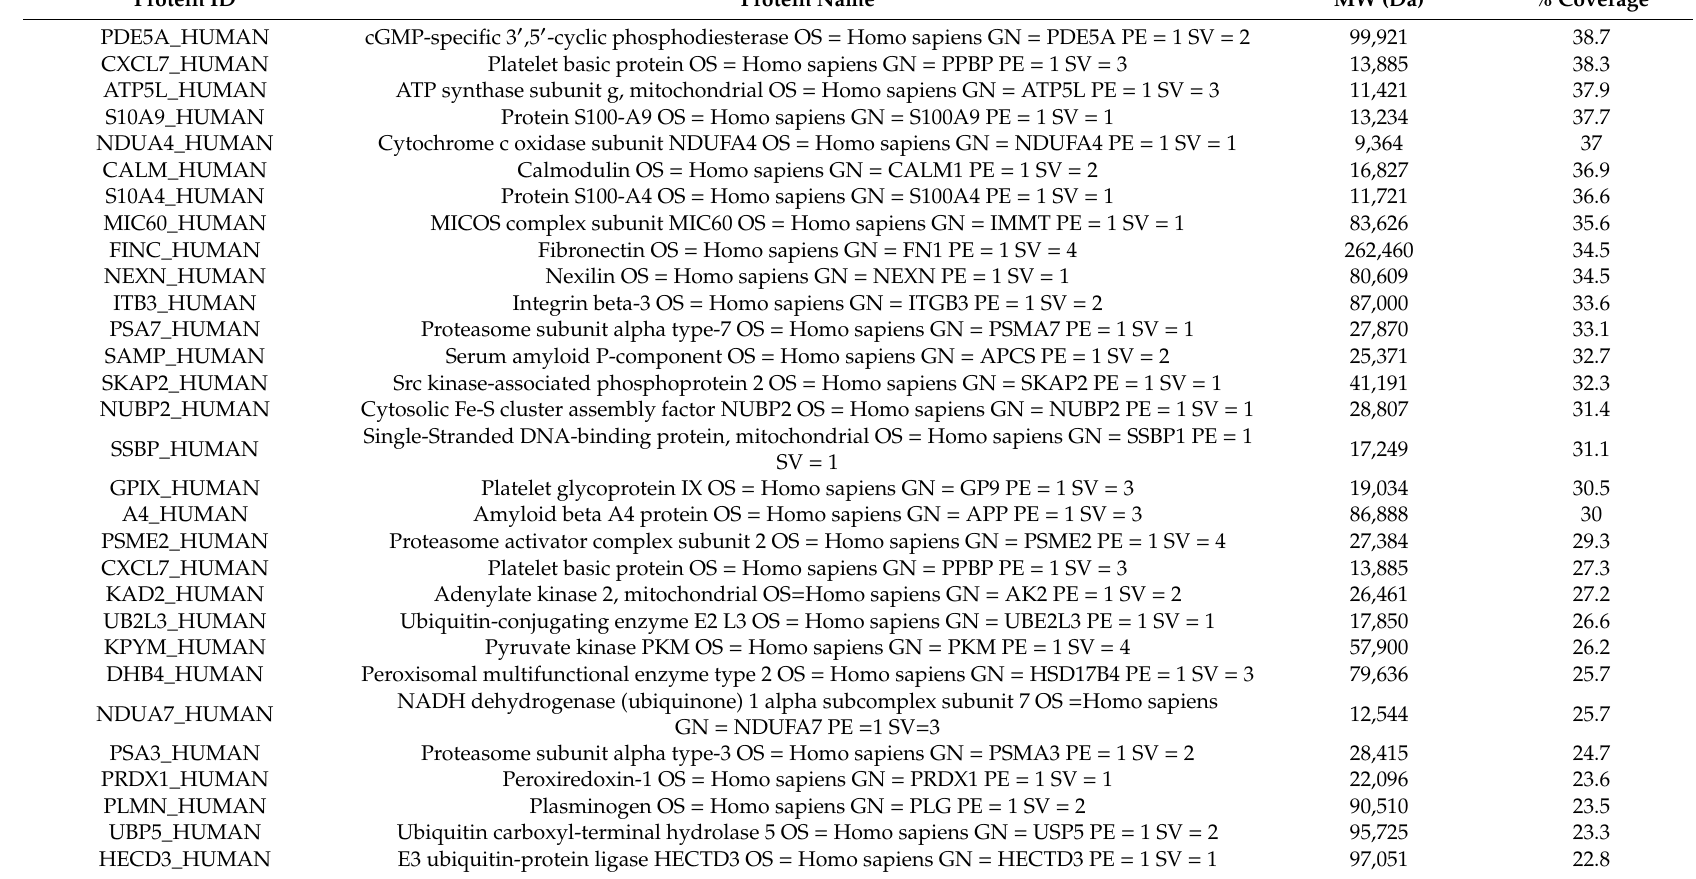
Table 2. Identification of Parkin-interacting proteins in DM platelets (39~20%